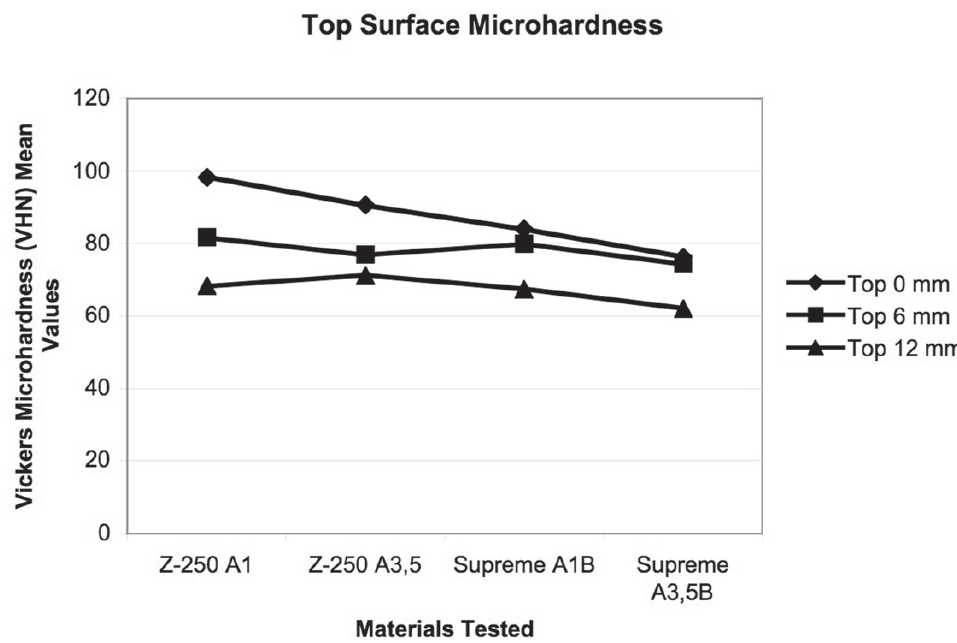
FIGURE 2- Top surface microhardness for the tested